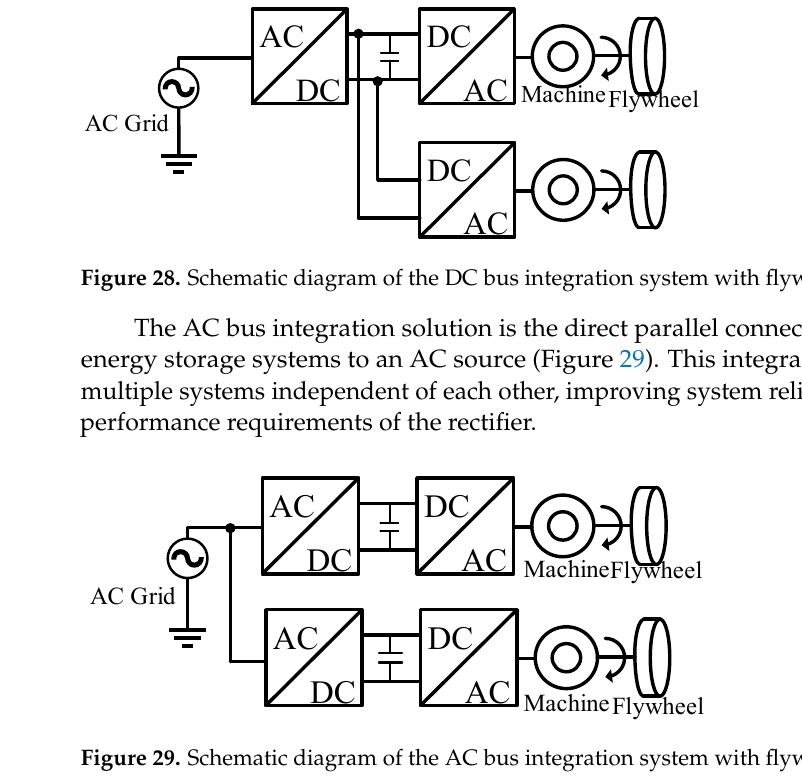
Figure 27. Topology of matrix converter with flywheel.